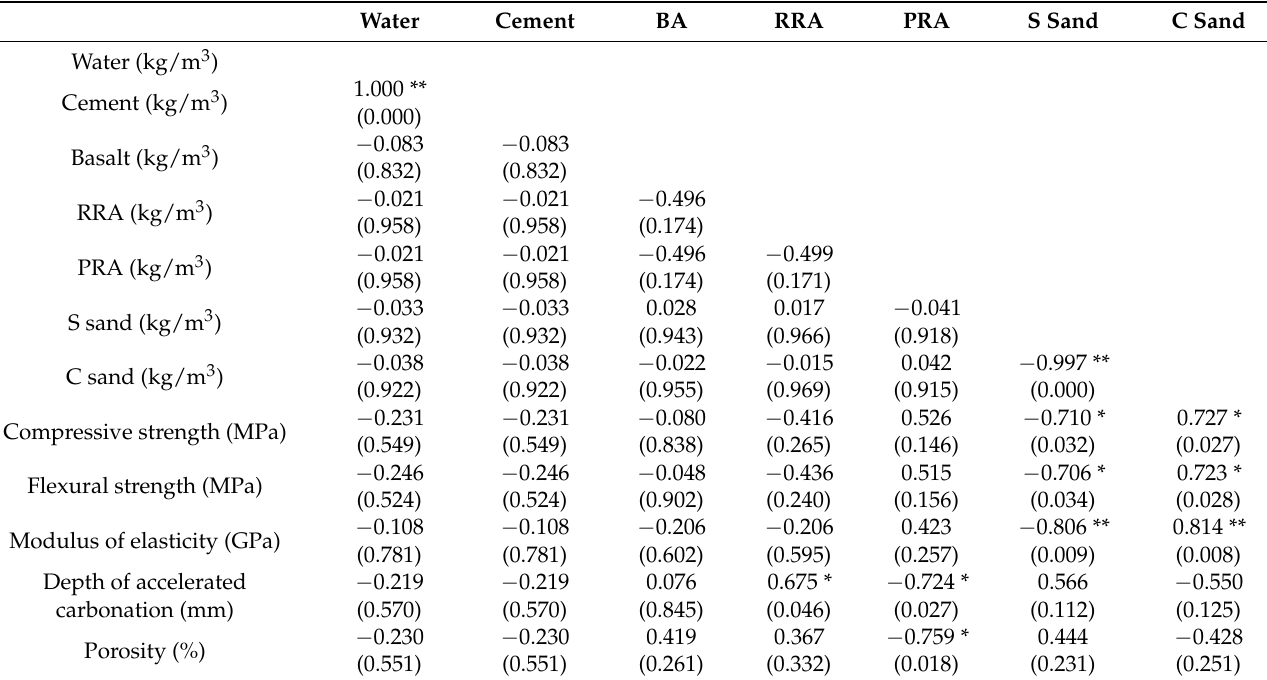
Table 9. Correlation analysis between the raw materials and mechanical